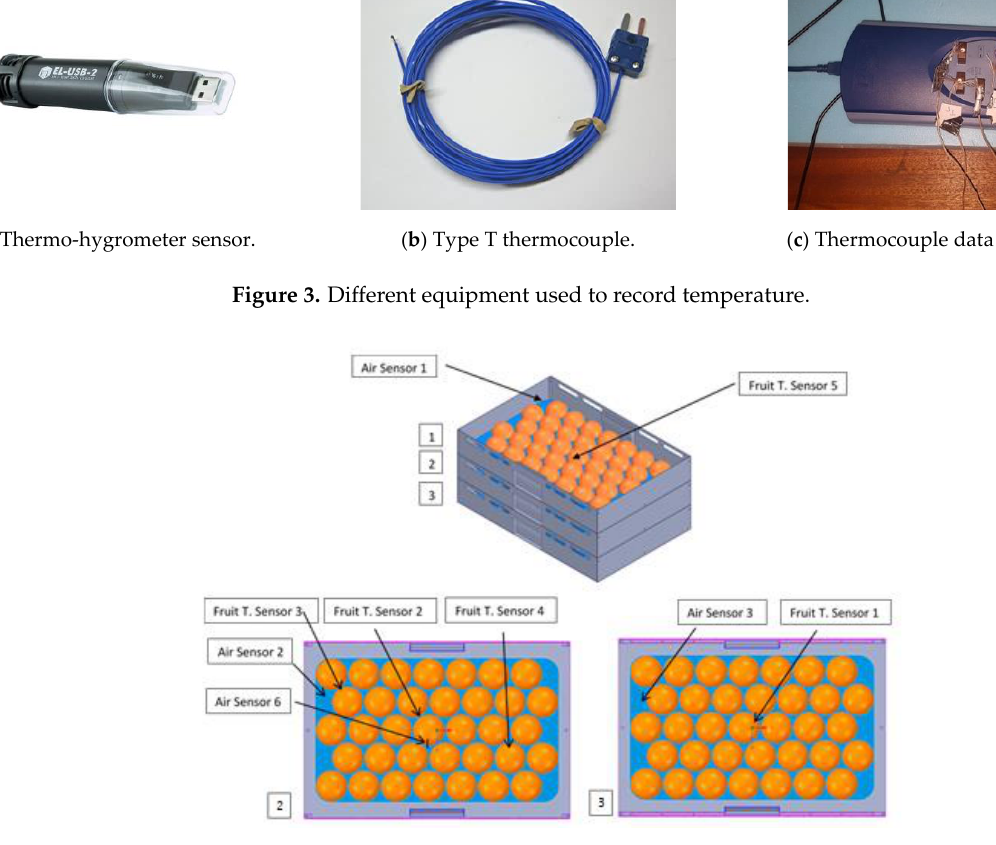
Figure 4. Positions of the sensors in the different packages.